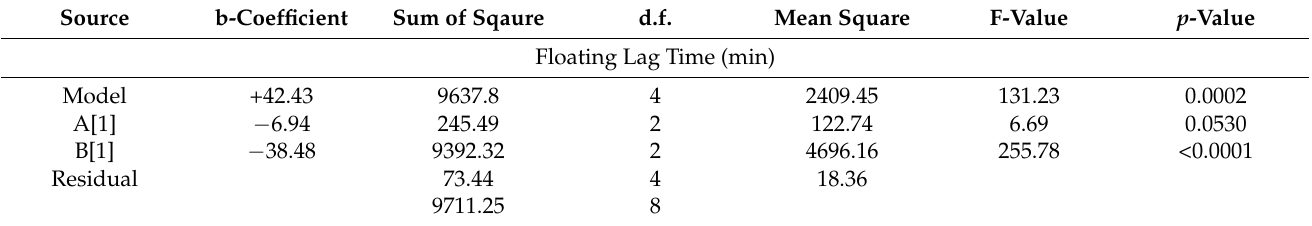
Figure 5. Predicted and actual value plots and 3D response surface plots showing the effect of independent variables, i.e., factor A (sodium alginate) and factor B (HPMC K4M), on response floating lag time. Table 8. ANOVA results for predicting floating lag time (min), % water uptake, and % drug release at 6 h and at 12